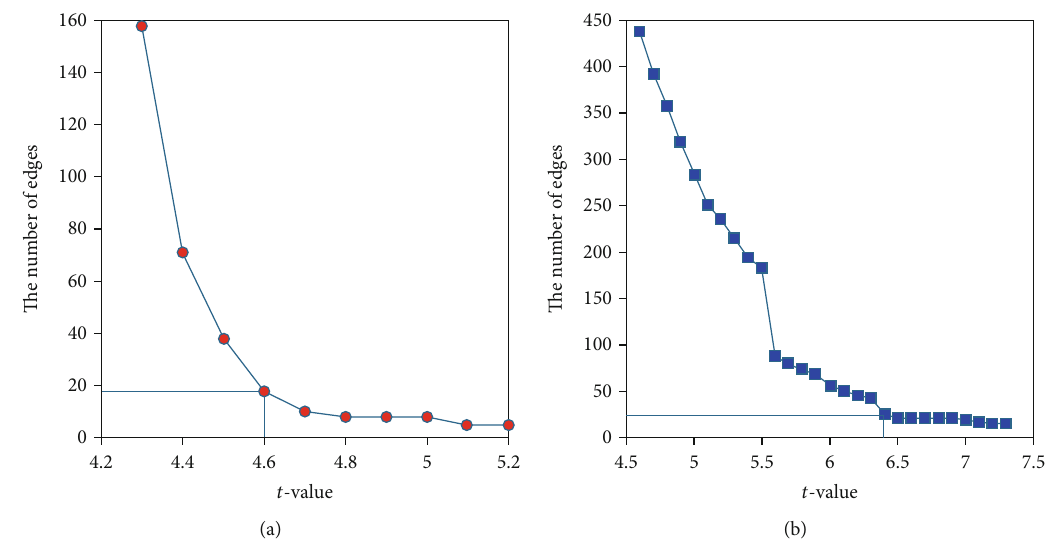
Figure 1: The number of connected edges varies with the threshold of the t -value from the network-based statistic method. (a) The in fl ection point occurs at the threshold of t = 4 : 6 for EMOTION versus resting state. (b) The in fl ection point occurs at the threshold of t = 6 : 4 for working memory versus resting state.